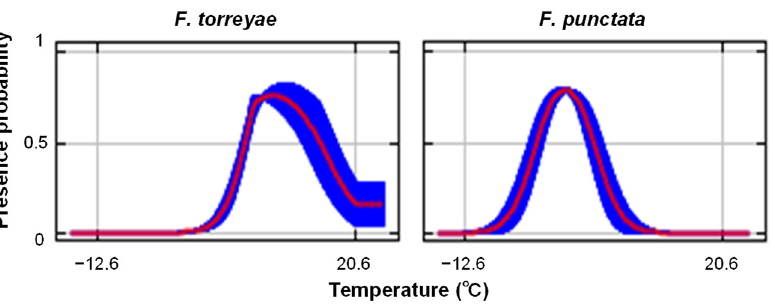
Figure 3. Relationships between presence probability and average temperature in March. Values were calculated in Maxent models using each variable alone. Red lines and blue shading show the mean of 100 bootstrap replicates and one standard deviation, respectively.